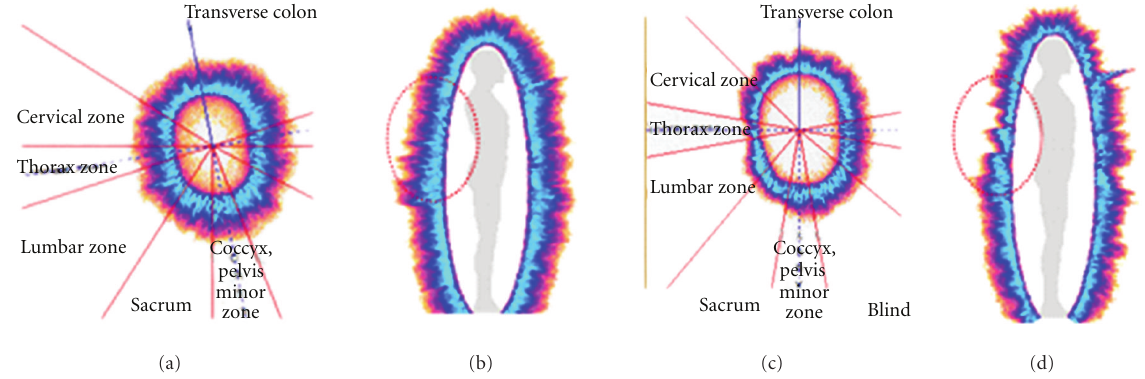
Figure 1: Images of the second finger of the right hand and respective lumbar and thorax zones in normal and disease states.